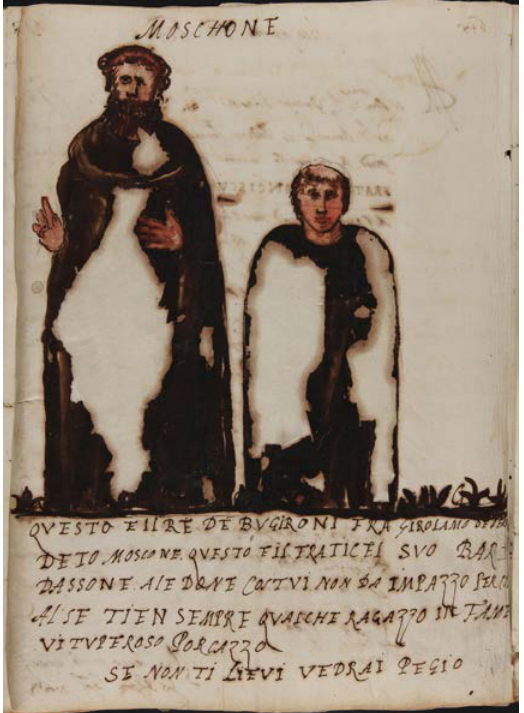
Figure 8 – Notarial reproduction of the defamatory libel against two friars published in Faenza. Courtesy of Ministero dei beni e delle attività culturali - Archivio di Stato di Bologna, Tribunale del Torrone, reg. 1648, c.